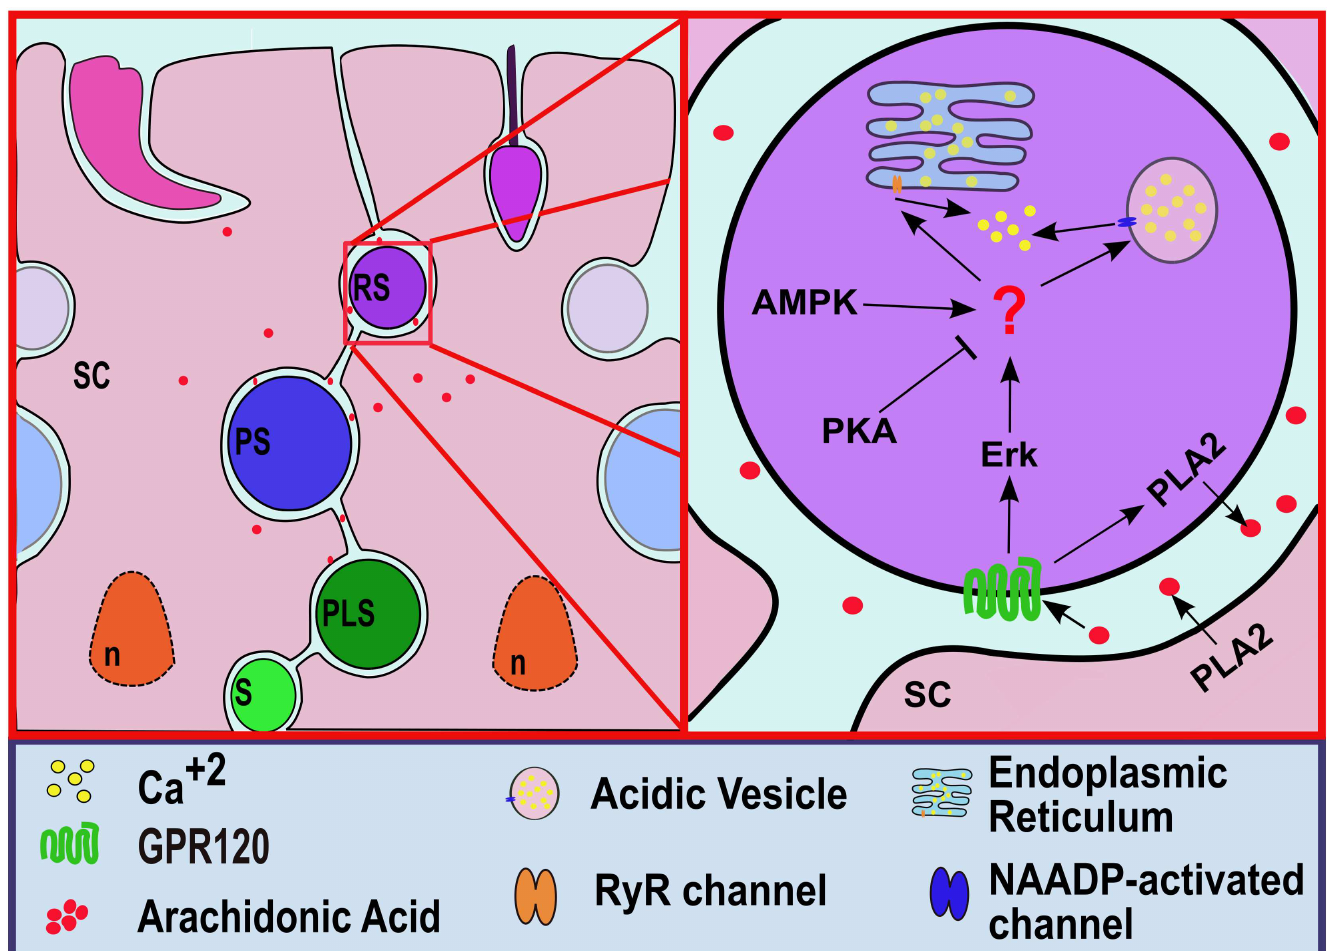
Fig 7. Summarydiagram. Diagramshowingthe likely activationmechanisms of PUFA release from Sertoli cells (SC) and their mechanisms of action on spermatogenic cell intracellular Ca 2+ stores.